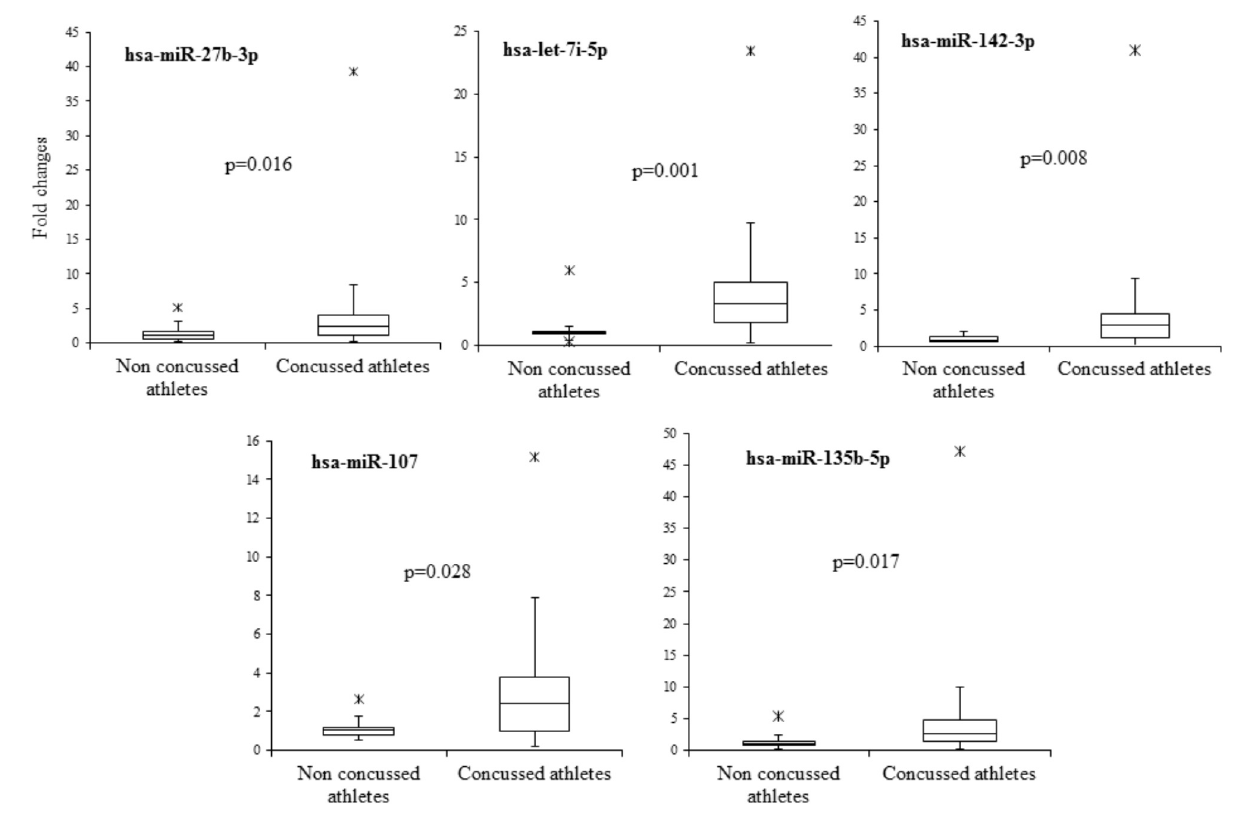
FIGURE 3 | Boxplot of the 5 candidate miRNA biomarkers. Boxplot of relative expression of the five microRNAs which showed a significant upregulation ( p < 0.05) in the validation group and assessed by RT-PCR. A non-parametric test (Mann–Whitney U test) was used to compare the level of microRNAs in the two independent